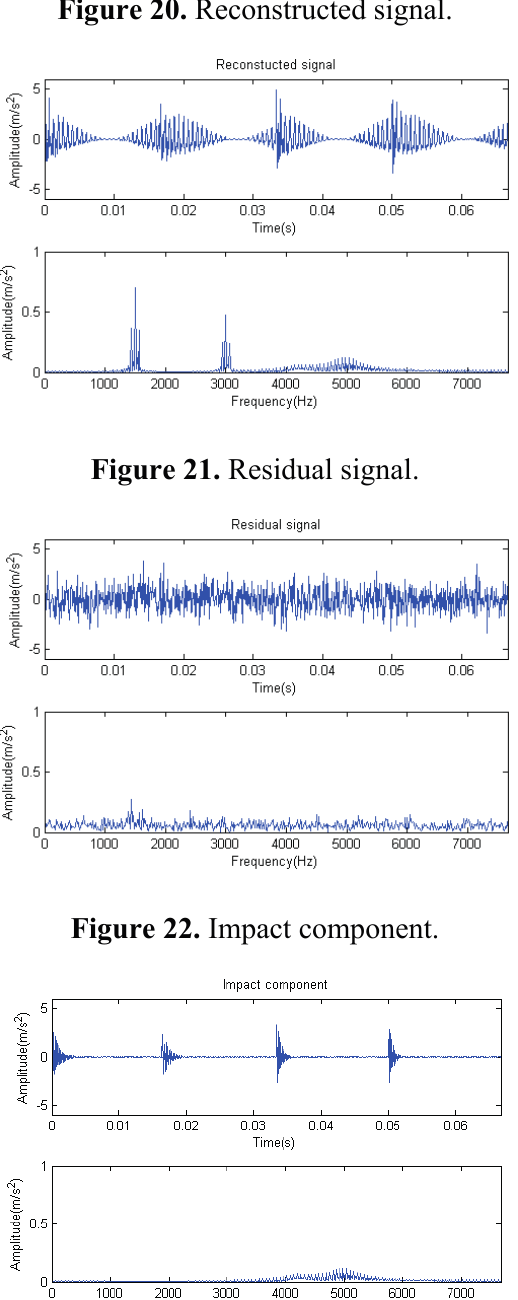
Figure 20. Reconstructed signal.